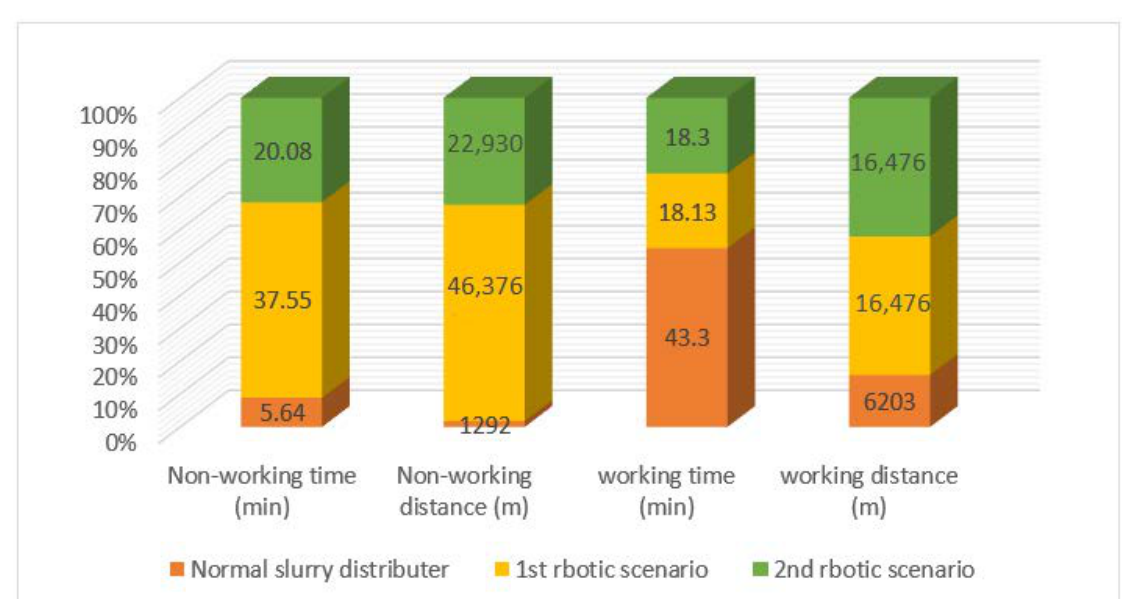
Figure 9. The comparison of operational properties between normal slurry distributer and robotic applications based on travel time, travel distance, working time, and working distance.